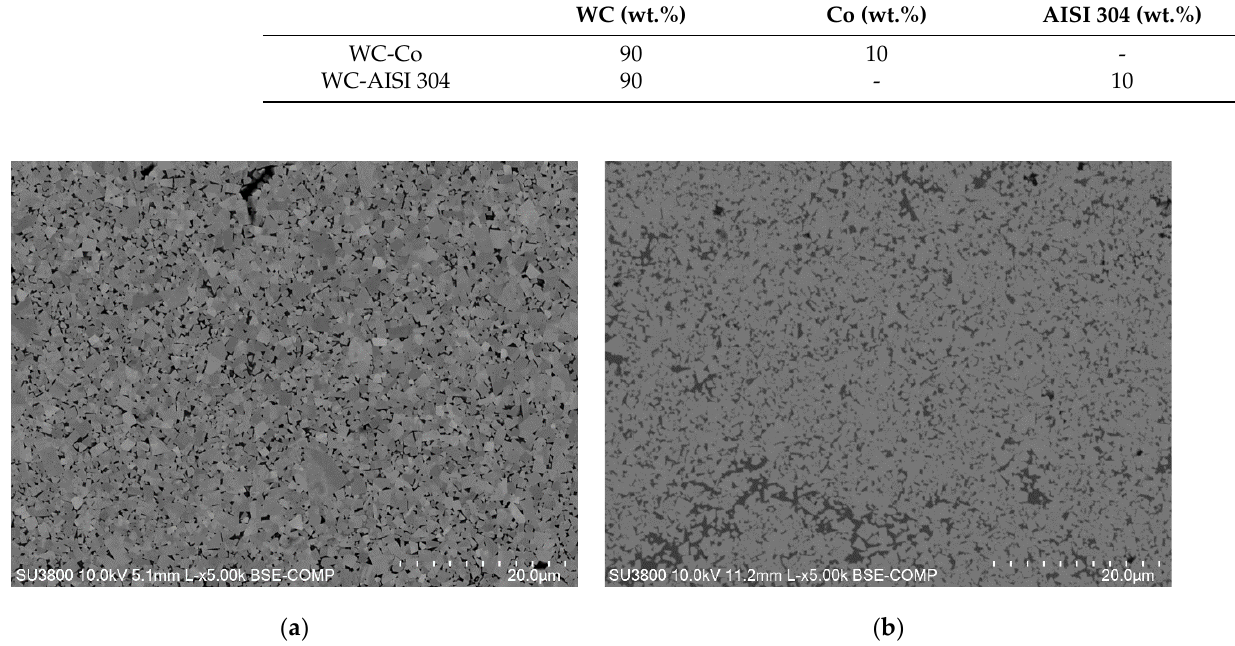
Figure 3. SEM micrographs of the: ( a ) WC-10Co composite and, ( b ) WC-AISI 304 composite.